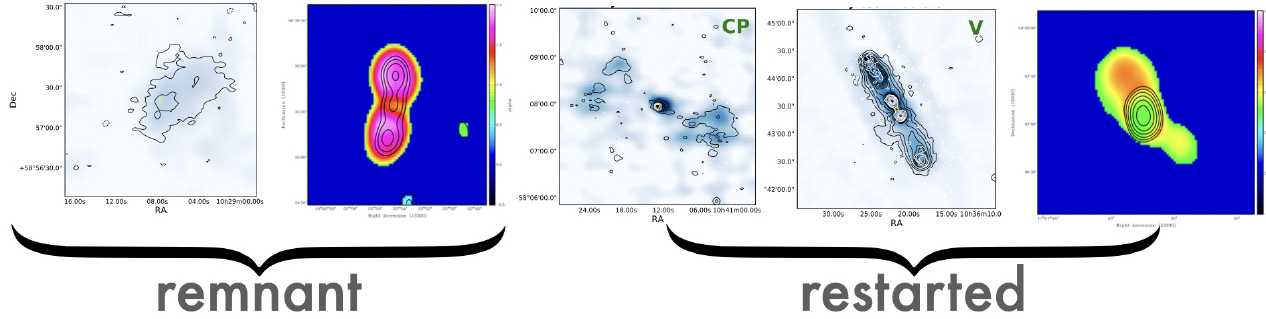
Figure 4. Examples of remnant and candidate restarted radio galaxies (from [34,38]). They were selected using different criteria. From left to right: two examples of remnant radio galaxies, the first selected based on the morphology of the emission at low frequencies from the LOFAR image [34], the second based on USS spectral indices [38]. The next three panels show examples of candidate restarted radio galaxies, the first two selected based on morphology [34], the third based on spectral index [38]. In the total intensity images, the black contours refer to the LOFAR emission, the white contours to FIRST data, and the yellow circle indicates the position of the optical counterpart (taken from [37]). The black contours in the spectral index maps represent the 1400 MHz emission from Apertif. As in Figure 3, the regions where no contours were drawn indicate regions undetected by Apertif, corresponding to spectral index lower